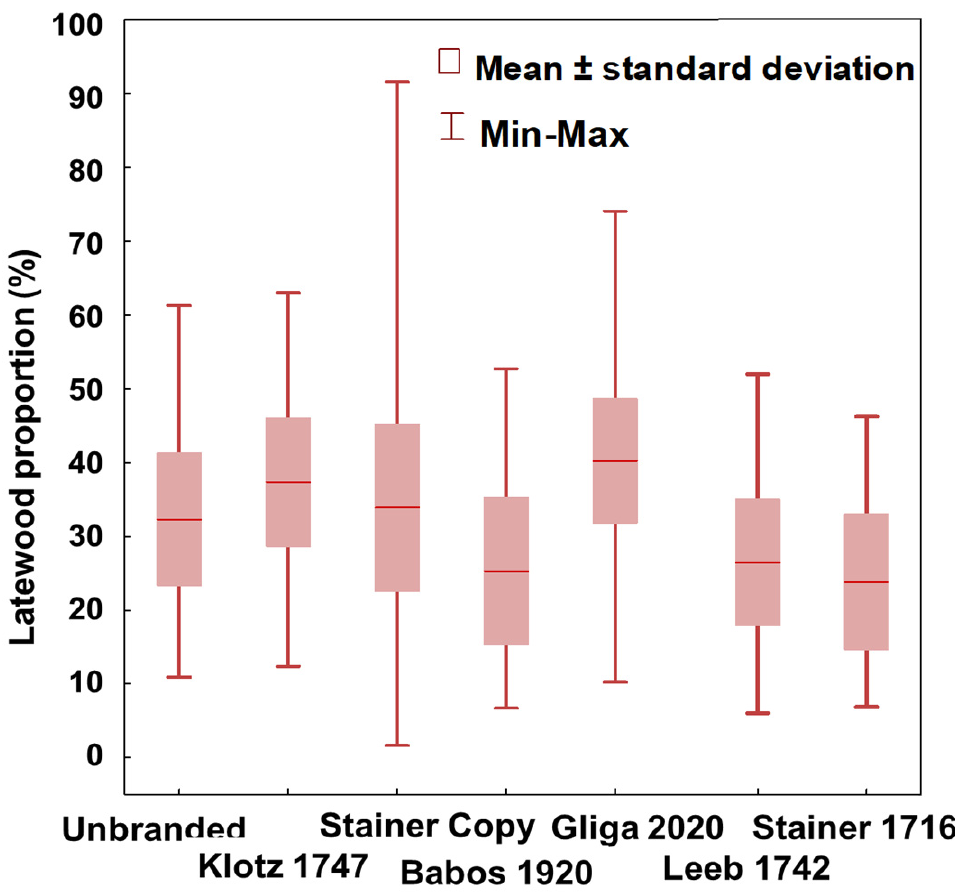
Figure 7. The variation of the proportion of late wood of top plates in the analyzed violins.